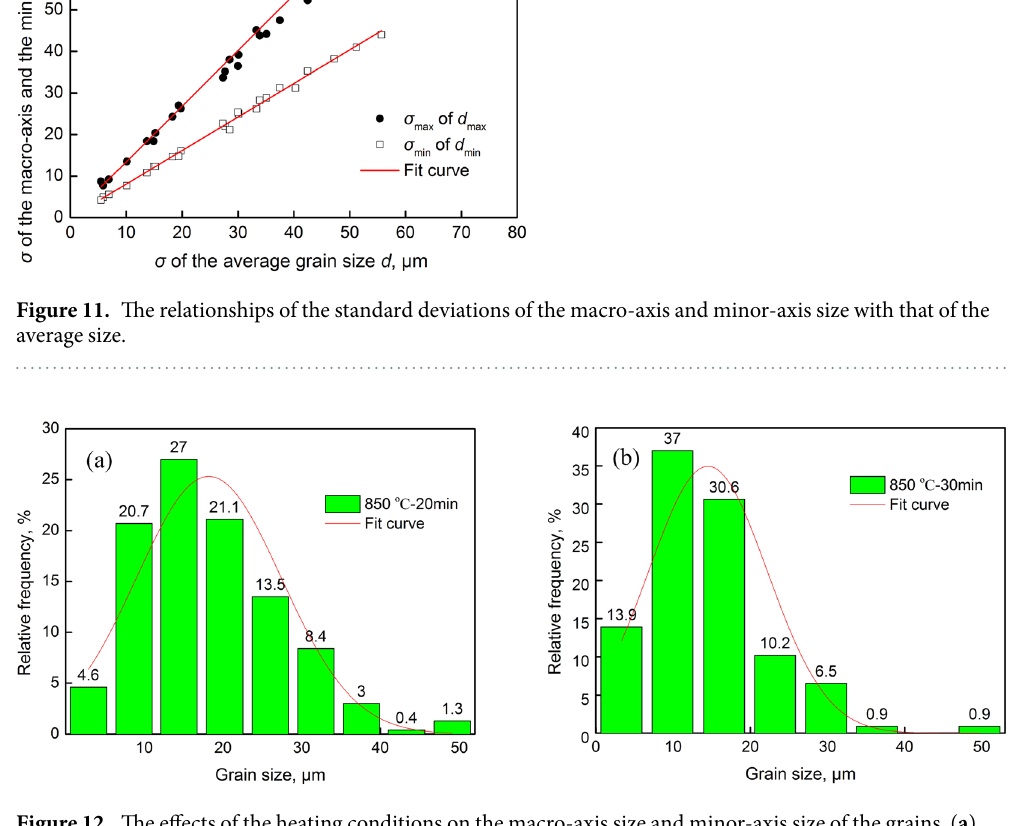
Statistics of the distributions of d max and d min . The experimental results indicated that the heating temperature and holding time had significant effects on the macro-axis size ( d max ) and minor-axis size ( d min ) of the austenite grains. Figure 12(a) shows the distribution of d max after heating at 850 °C for 20 min. Measurements of the d max of